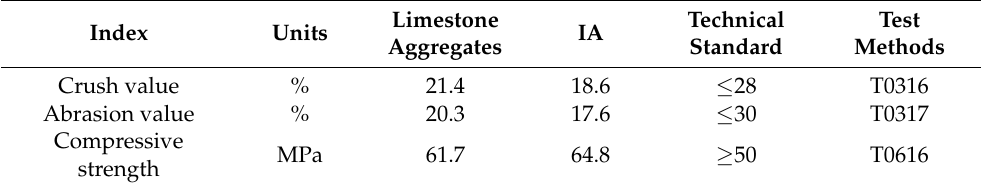
Table 9. Comparison of technical properties between the IA and traditional limestone aggregates.